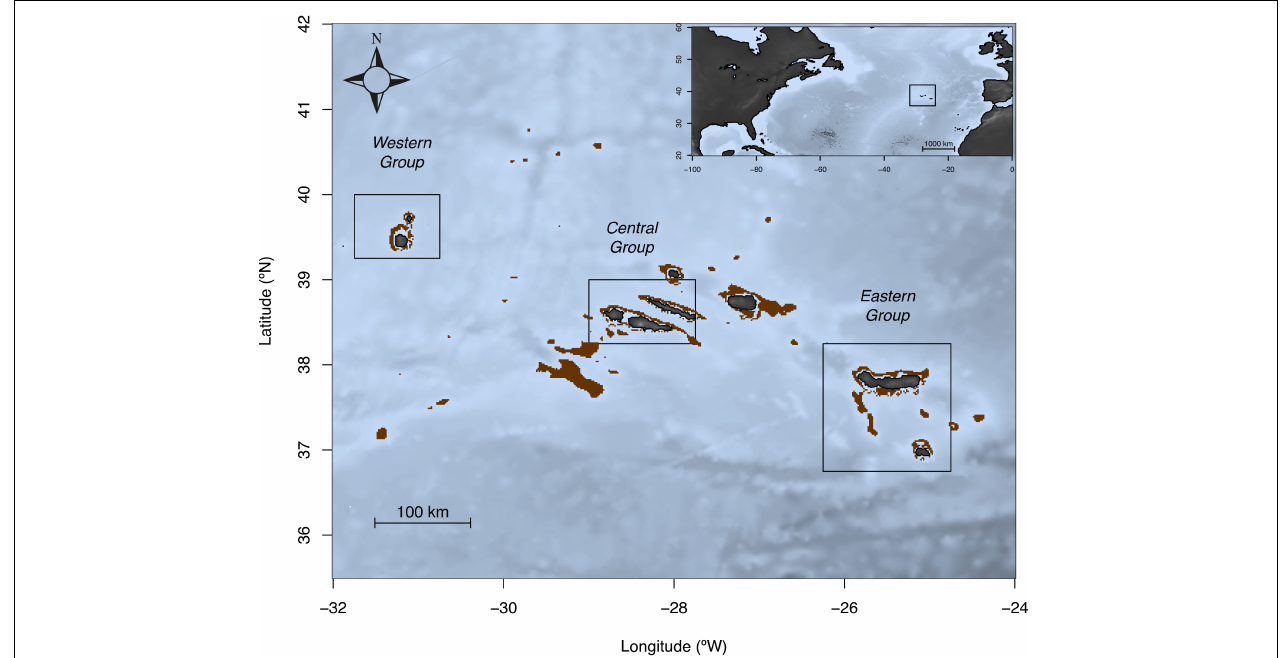
FIGURE 1 | Sampling locations map of Pagellus bogaraveo in the Azores. Boxes in each sampling location indicate areas for which temperature-at-depth was obtained. Brown areas represent the depth range where the species generally occurs.